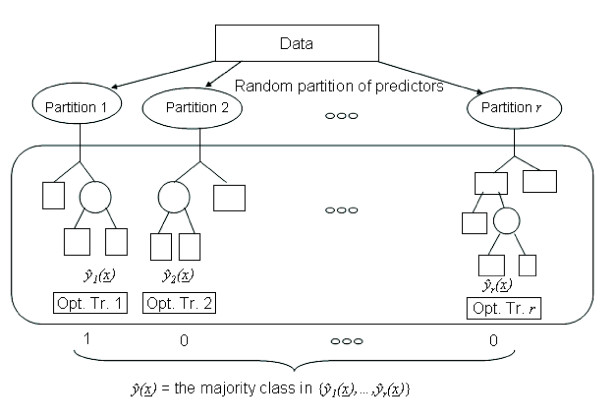
An ensemble in CERP.